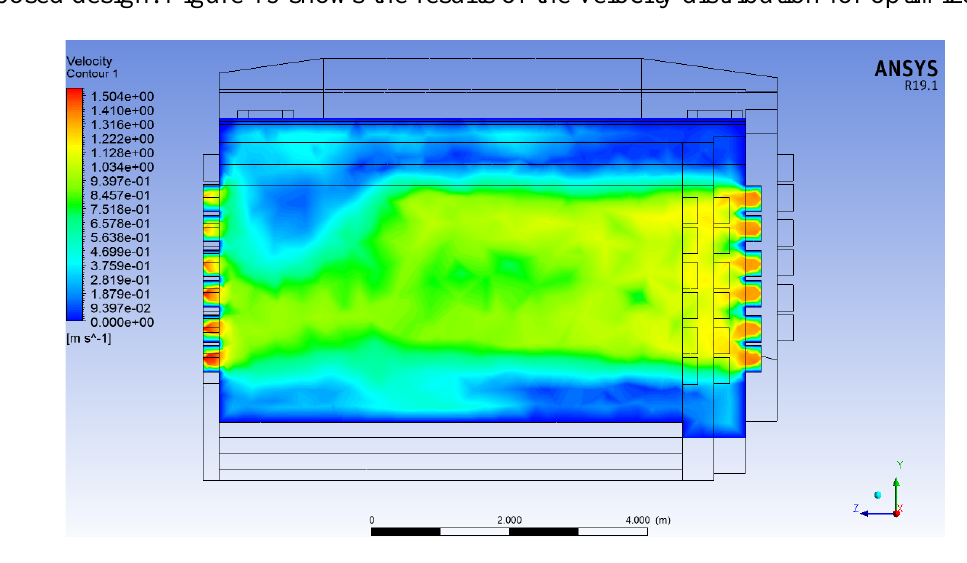
Figure 13. Optimized Design Velocity